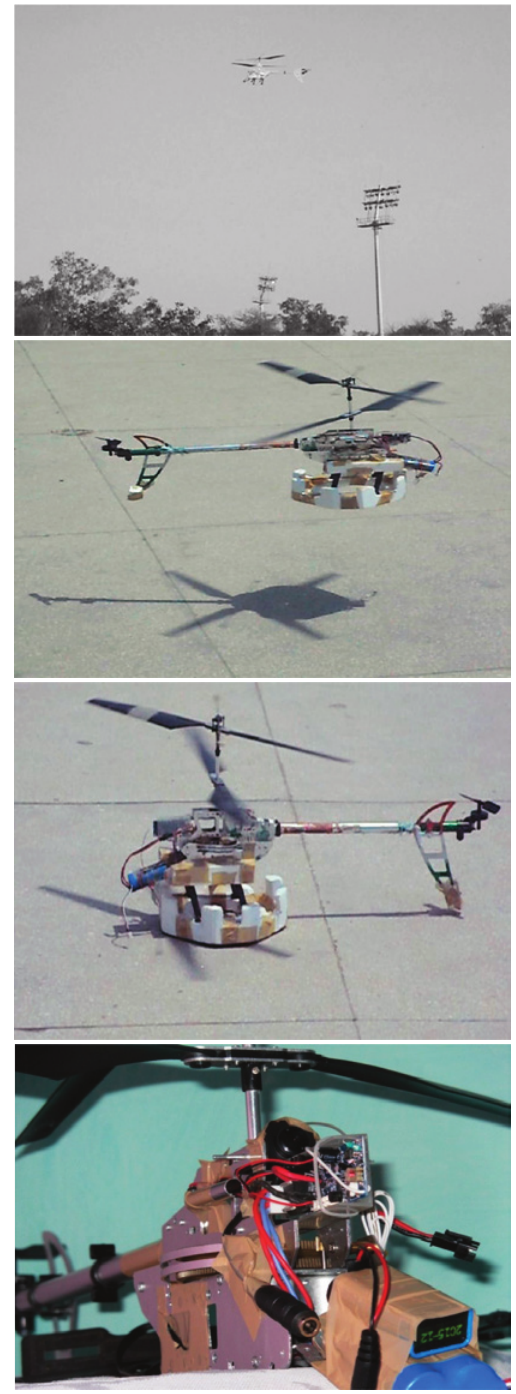
Fig. 1. A close look at the coaxial rotor aerial